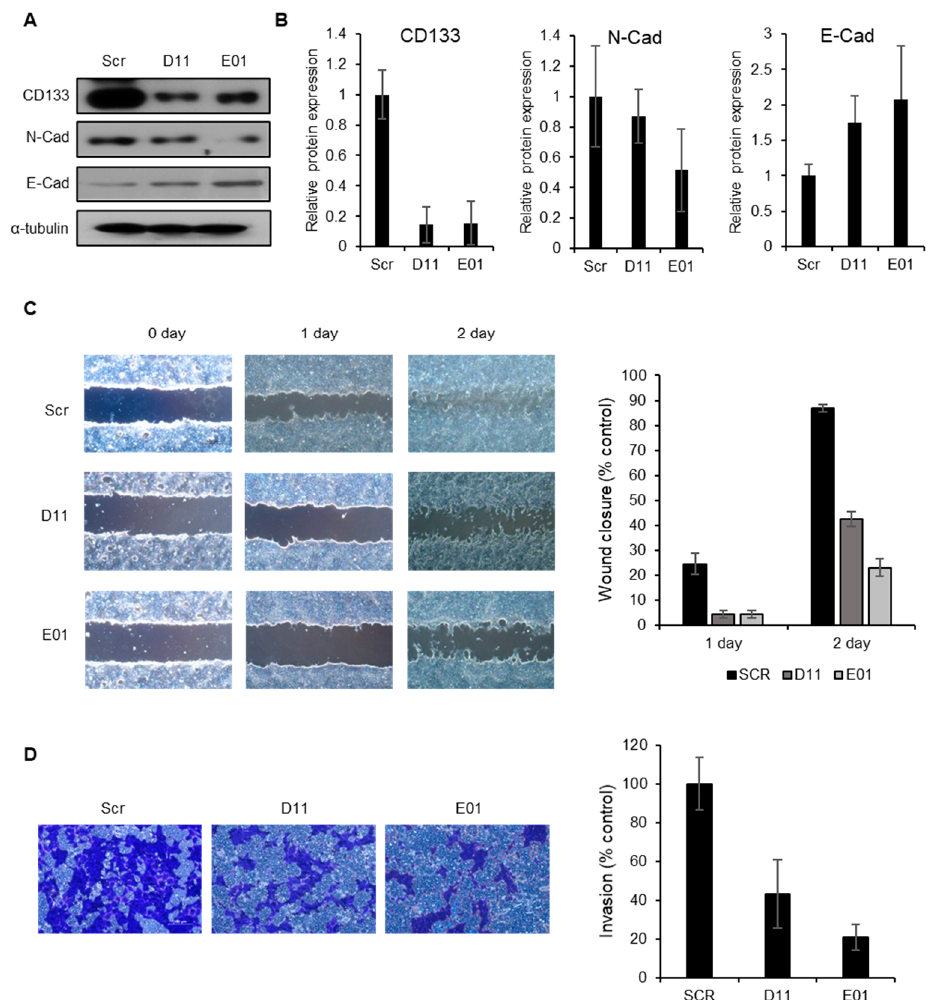
Figure 5. E ff ect of CD133 knockdown on EC cell migration and invasion. ( A ) Expression of CD133, N-cadherin, and E-cadherin was analyzed by immunoblotting. Alpha-tubulin was used as an